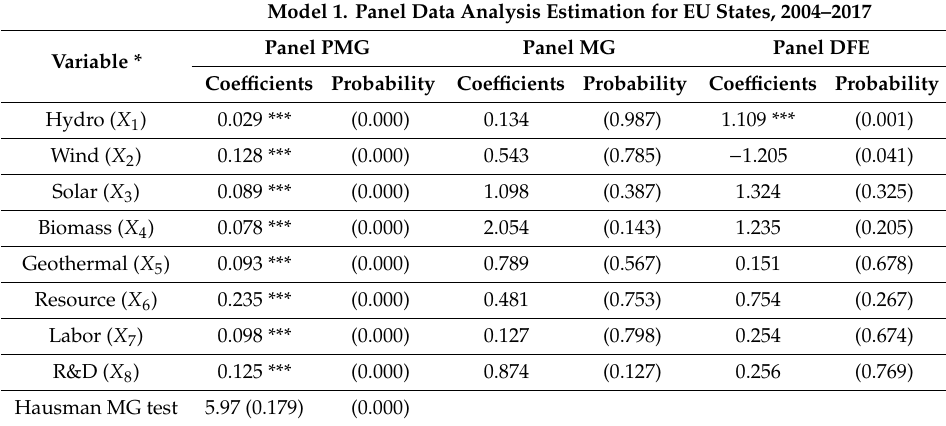
Table 7. Summary of the panel regression model 1 for the EU countries during 2004–2017. Model 1. Panel Data Analysis Estimation for EU States,